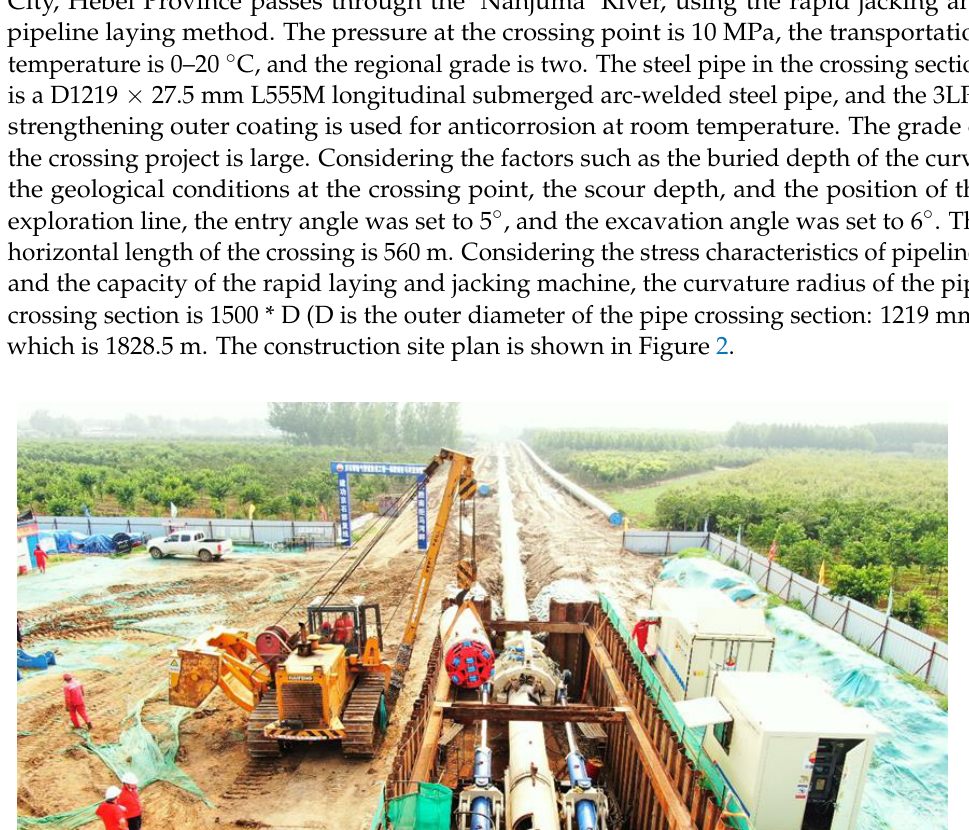
Figure 3. Geological profile of this project. Table 2. Summary of soil properties. Layer